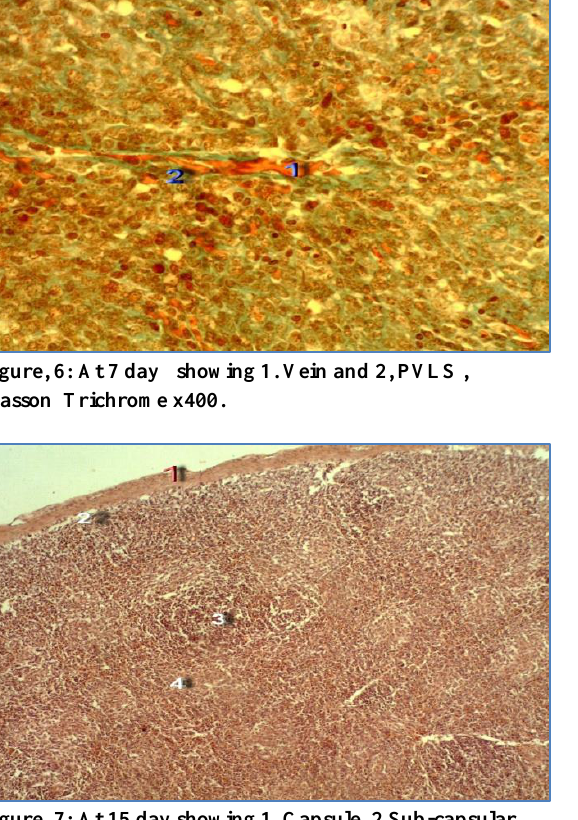
Figure, 7: At 15 day showing 1. Capsule, 2.Sub-capsular tissue, 3.Red pulp and 4.White pulp, H and E X100.